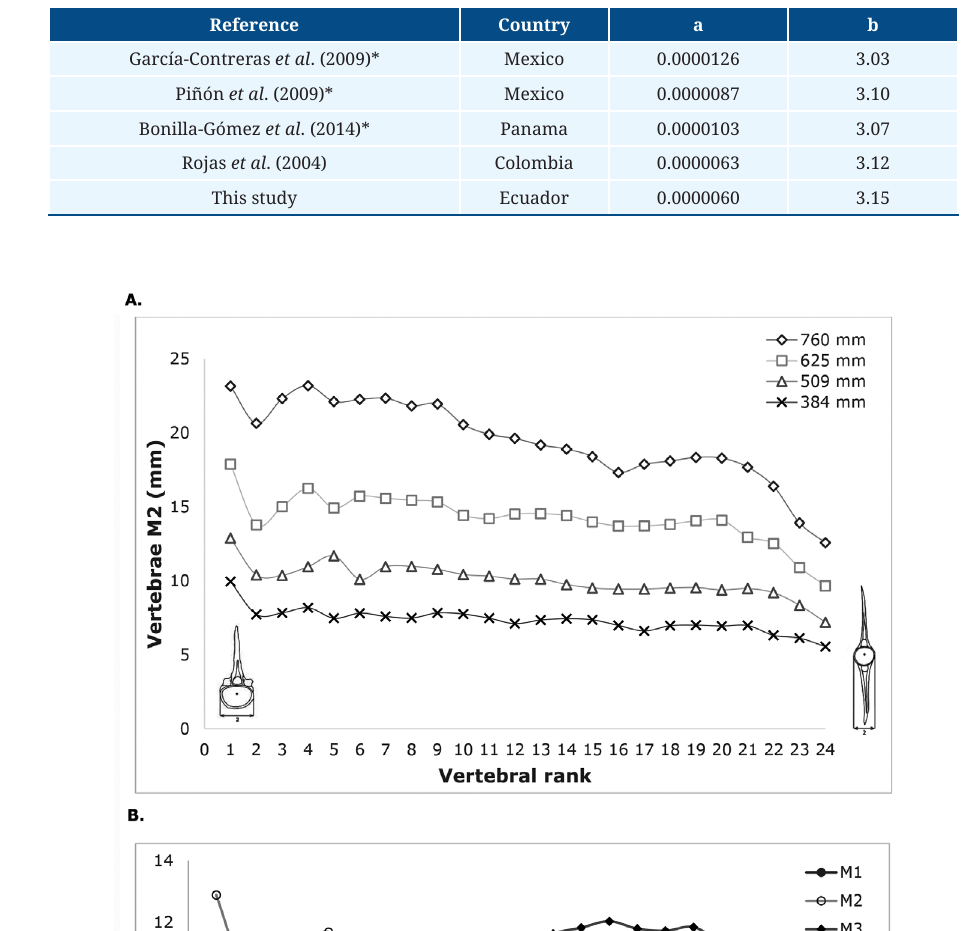
TABLE 4 | Lutjanus argentiventris total length to weight equation parameters from Mexico, Panama and Colombia (*data in cm were transformed into mm).